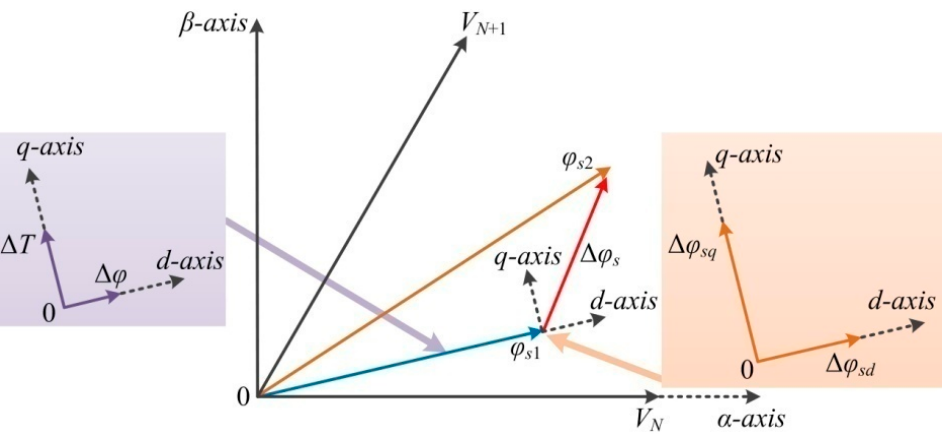
Figure 4. Analysis of error compensational effects.